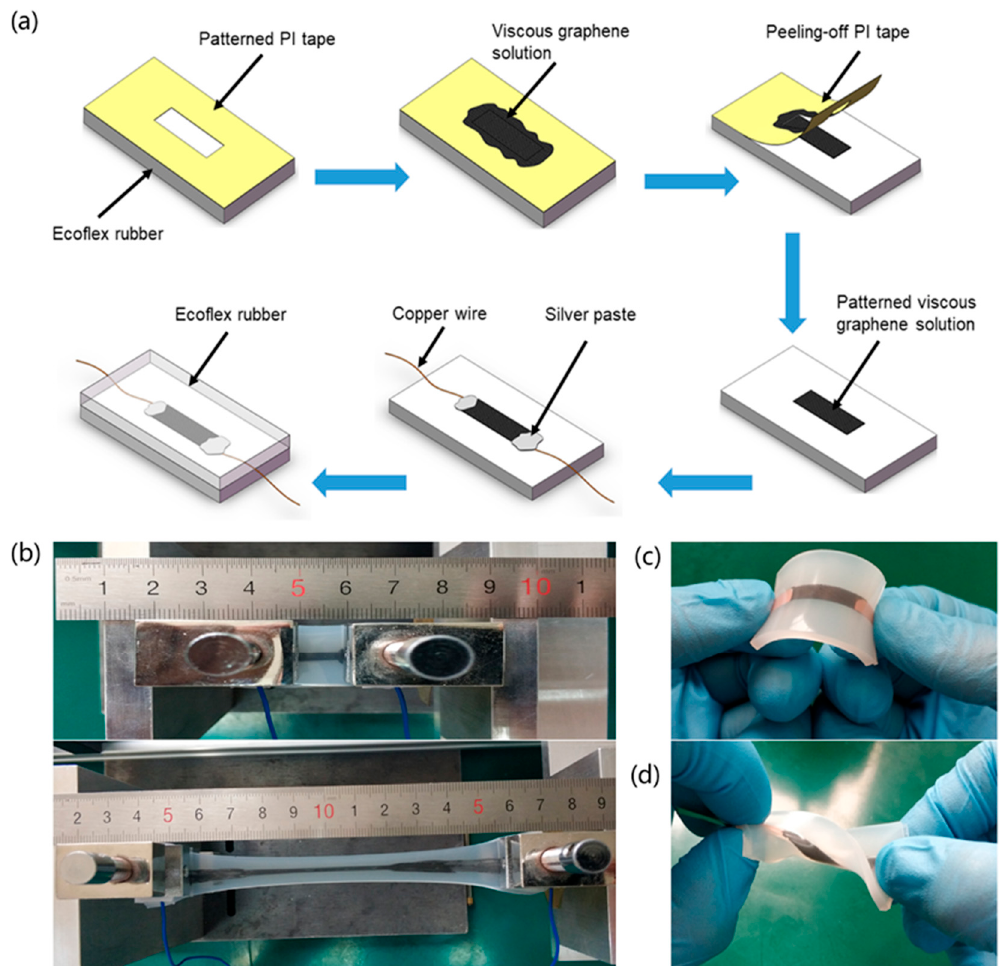
Figure 1. Fabrication process and result of the sandwich-structured Ecoflex rubber and graphene solution strain sensor: ( a ) fabrication process, ( b ) the strain sensor before and after stretching to ε = 1000%, the strain sensor under bending ( c ), and twisting ( d ).